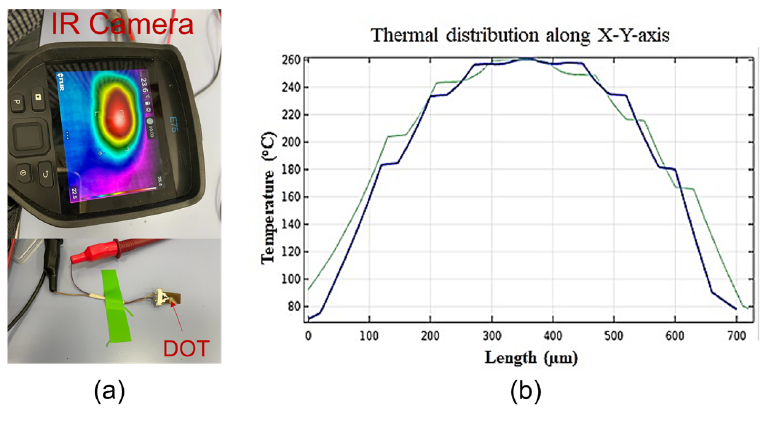
Figure 12. ( a ) Microscopic thermal characterizations with IR camera, ( b ) Thermal distribution of the top surface of the microheater.